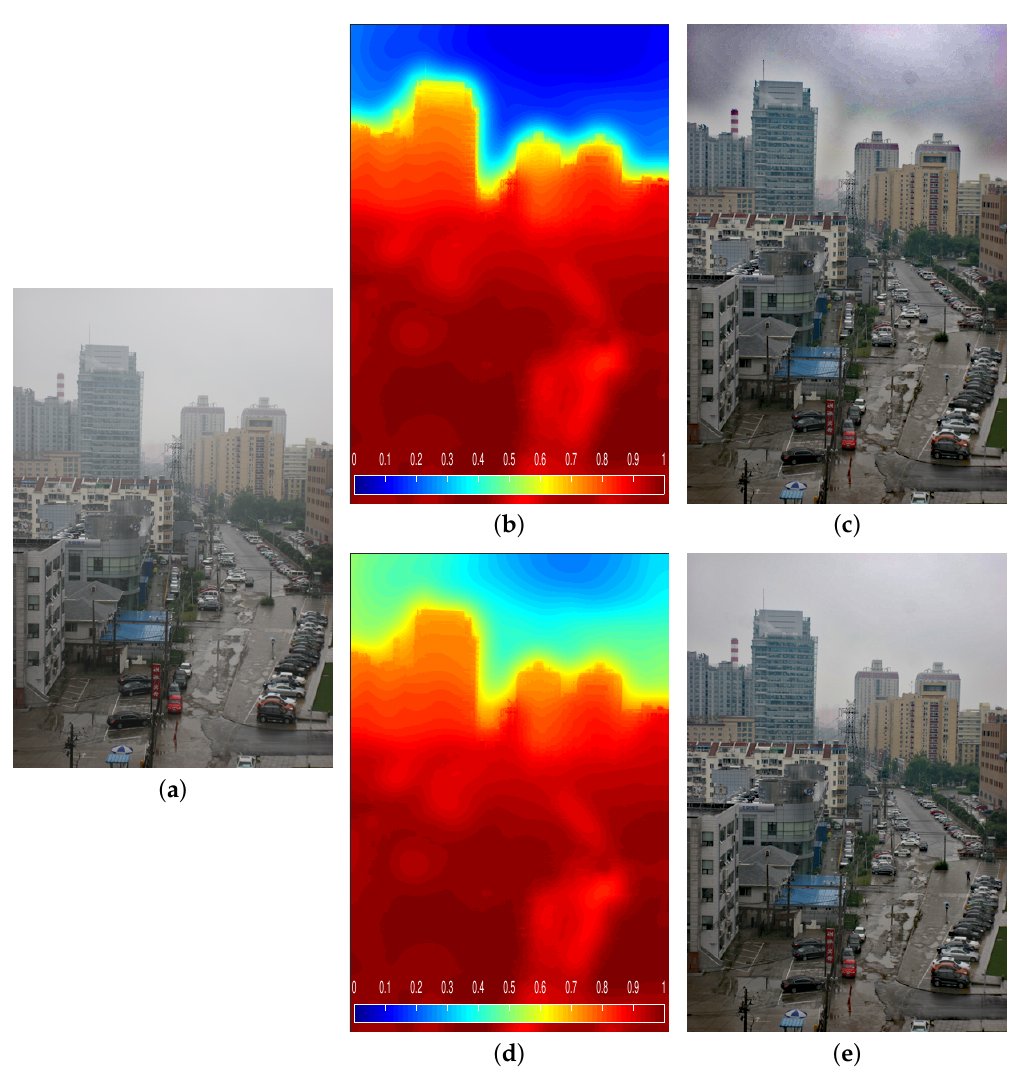
Figure 1. Effect of offset correction in our proposed method. ( a ) Foggy image; ( b ) the transmission of DCP; ( c ) the result of DCP; ( d ) our offset-corrected transmission; ( e ) our result with offset